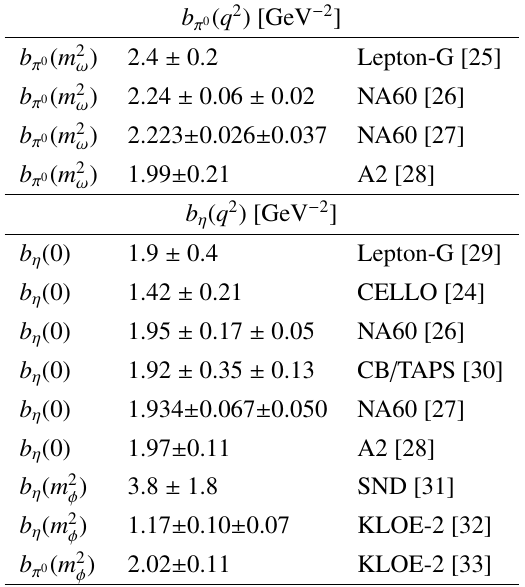
Table 1. Summary of the experimental data on the π 0 and η TFFs slopes b ( q 2 ) and b η ( q 2 ). π 0